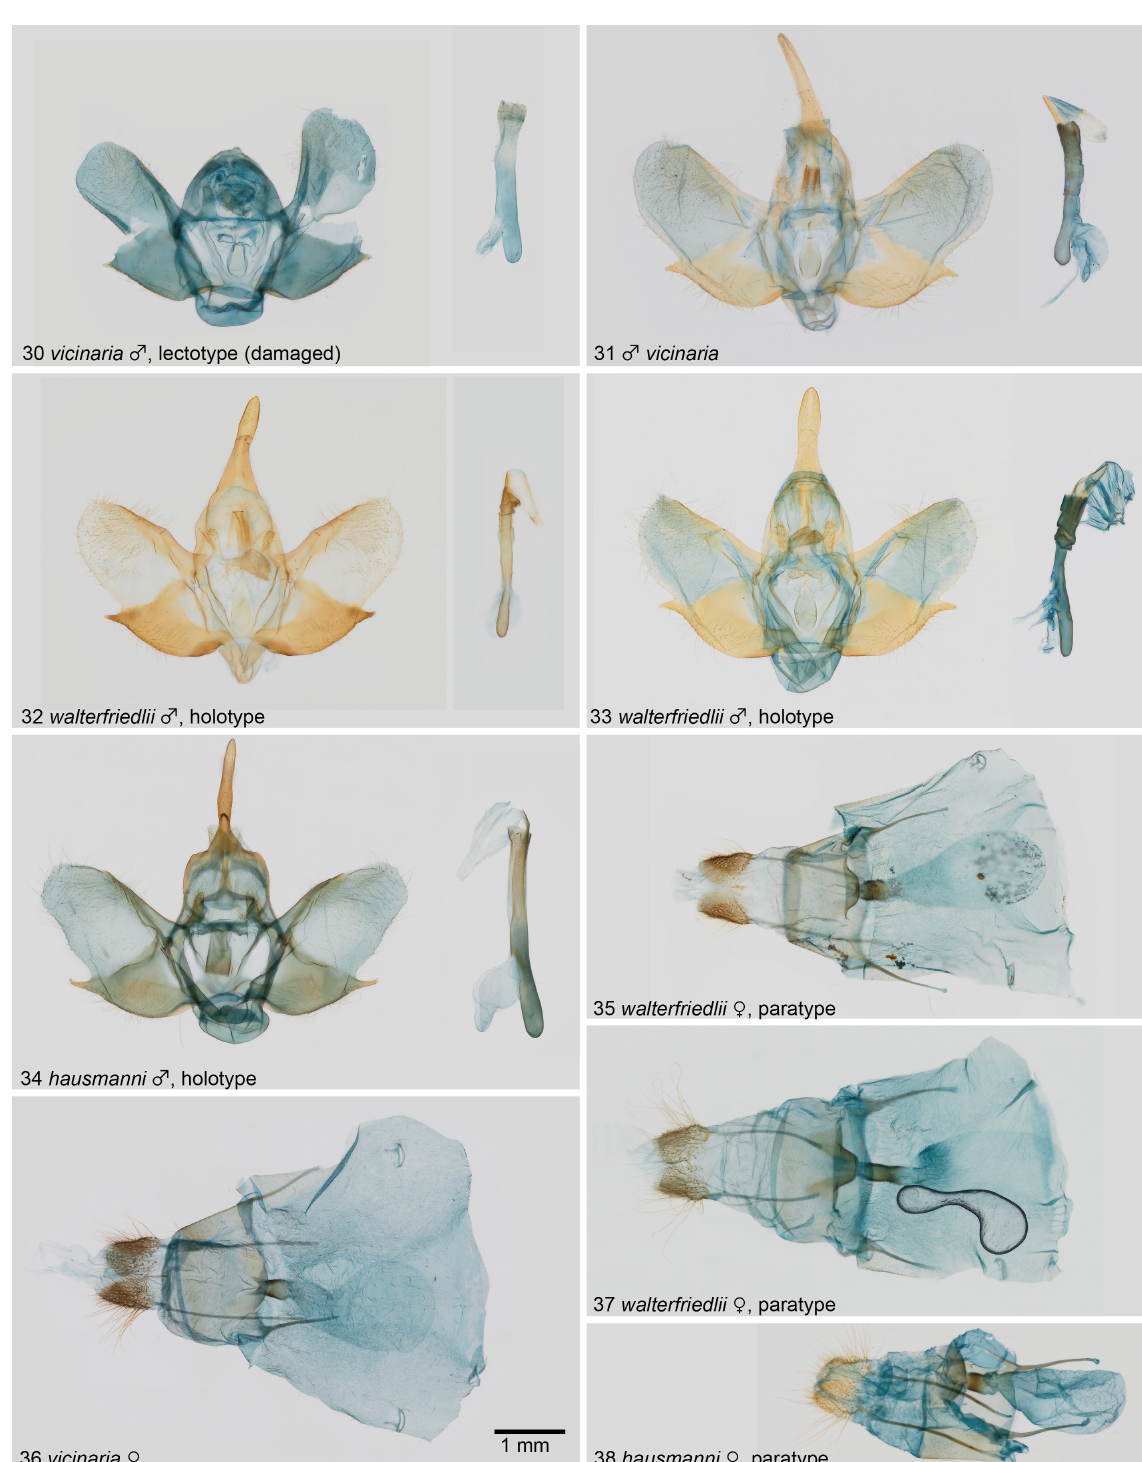
Figs 30–38. Male and female genitalia (left = valves; right = aedeagus). 30 . Callipia vicinaria Dognin, 1913, ♂, lectotype (C-0197). 31 . C. vicinaria Dognin, 1913, ♂ (C-0198). 32 C. walterfriedlii sp. nov., ♂, holotype (C-0068, COI data). 33 . C. walterfriedlii sp. nov., ♂, paratype (C-0065, COI